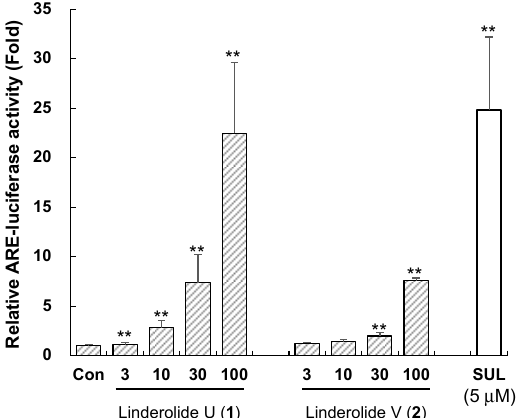
Figure 6. The relative antioxidant response element (ARE)-luciferase activities of isolated compounds 1 and 2 . The ARE induction activities were evaluated in ARE-HepG2 cells at concentrations applied at each assigned weight ratio (based on 30 μ g/mL crude extract. Data are presented as the mean ± S.E. ( n = 3). ** p < 0.01 (compared with the vehicle-treated control). SUL: Sulforaphane was treated as a positive control.